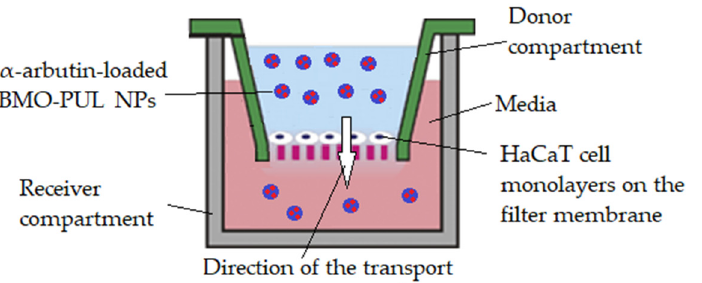
Figure 1. Illustration of the modified Transwell-type HaCaT model employed in these studies.